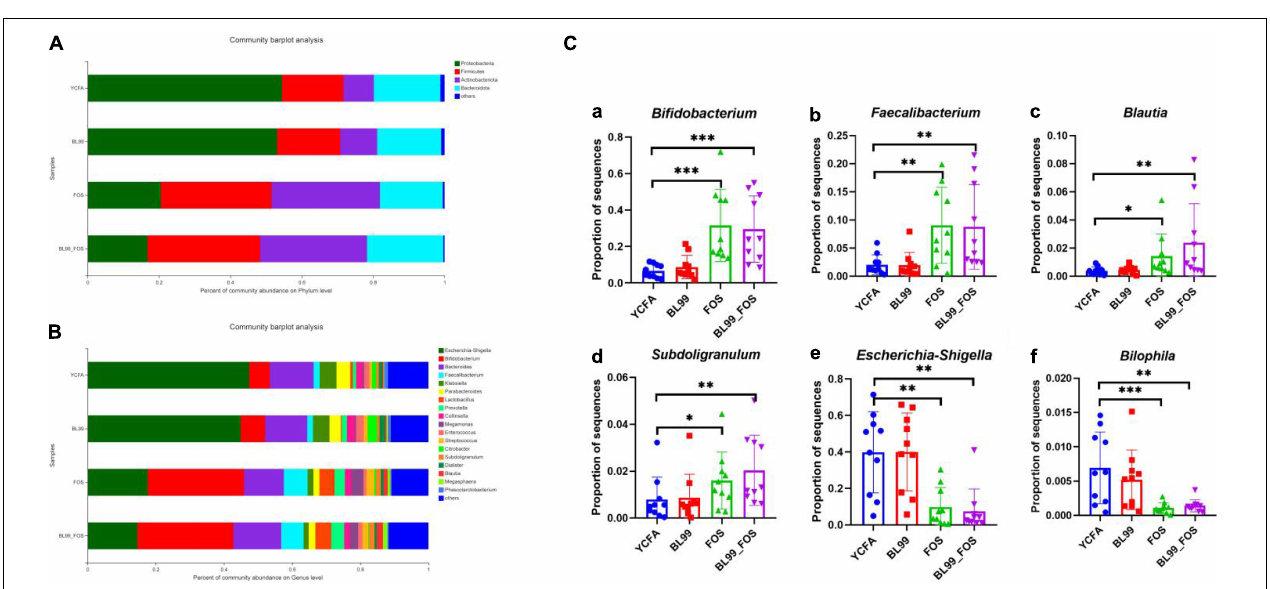
FIGURE 4 | Histogram of species composition at the phylum (A) and genus (B) level and relative abundance of dominant species in different groups (C) [Bifidobacterium (a) ; Faecalibacterium (b) ; Blautia (c) ; Subdoligranulum (d) ; Escherichia-Shigella (e) ; and Bilophila (f) ]. Statistical significance was calculated by one-way ANOVA with LSD test, * P < 0.05, ** P < 0.01, and *** P < 0.001 were considered with significant